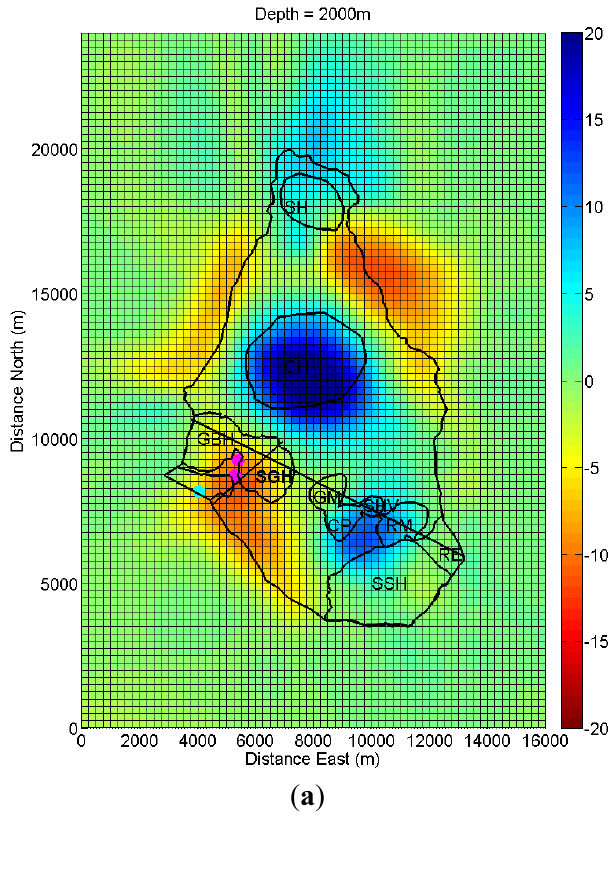
Figure A1. P-wave tomography results from Shalev et al. [13] displayed as perturbation from the average velocity at each depth. Blue represents faster velocities and red represents slower velocities. ( a ) map view slice through the target volume at 2000 m depth; ( b ) E-W cross-sections through target volume at 8750 m north; and ( c ) 6750 m north; ( d ) N-S cross-section through target volume at 5250 m east; and ( e ) 6250 m east. The NW trending black line indicates a zone of structural weakness identified by Wadge and Isaacs [34]. The NE trending black line indicates a fault plane identified from earthquake hypocenters beneath St. George’s Hill [9]. The magenta dots relate to the locations of wells MON-1 and MON-2. The cyan dot relates to the location of the alkali-chloride hot spring at Hot Water pond. GBH (Garibaldi Hill); SGH (St. George’s Hill); GM (Gage’s Mountain); CP (Chances Peak); SHV (Soufrière Hills Volcano); RM (Roche’s Mountain); SSH (South Soufrière Hills); RE (Roche’s Estate); CH (center Hills); SH (Silver Hills). The colour scale indicates % velocity